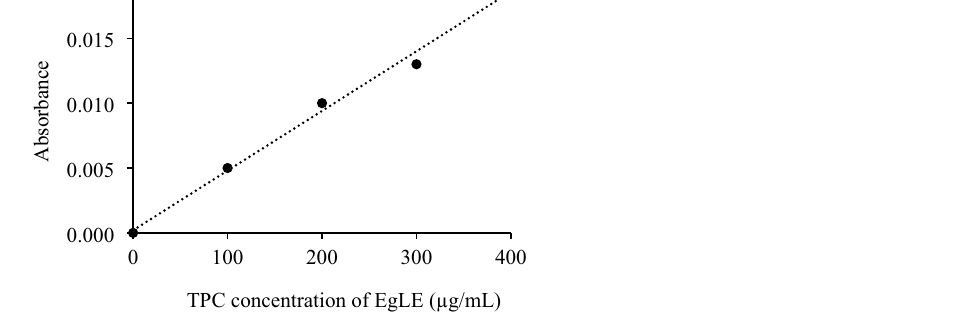
Figure 3. Calibration curve for TPC of EgLE.